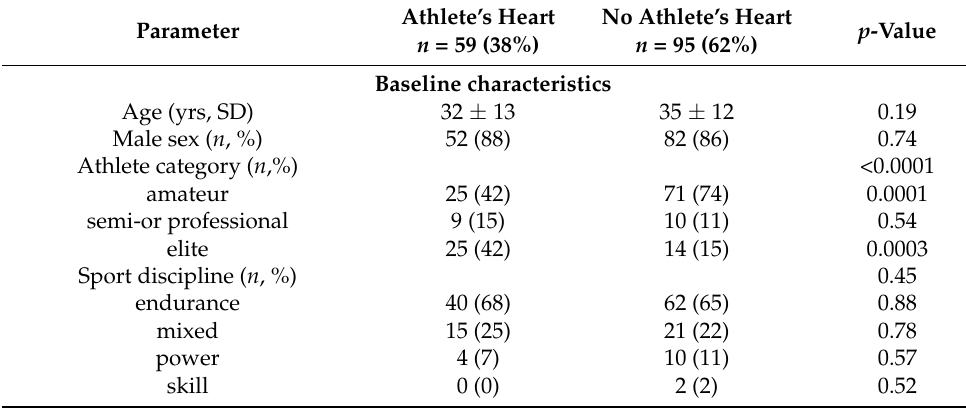
Figure 2. 4-chamber view. Examples of a patient with athlete’s heart (AH) features (( A )—end-diastole, ( B )—end-systole) and without AH features (( C )—end-diastole, ( D )—end-systole). Table 2. Baseline characteristics and cardiac magnetic resonance (CMR) results in patients with and without athlete’s heart